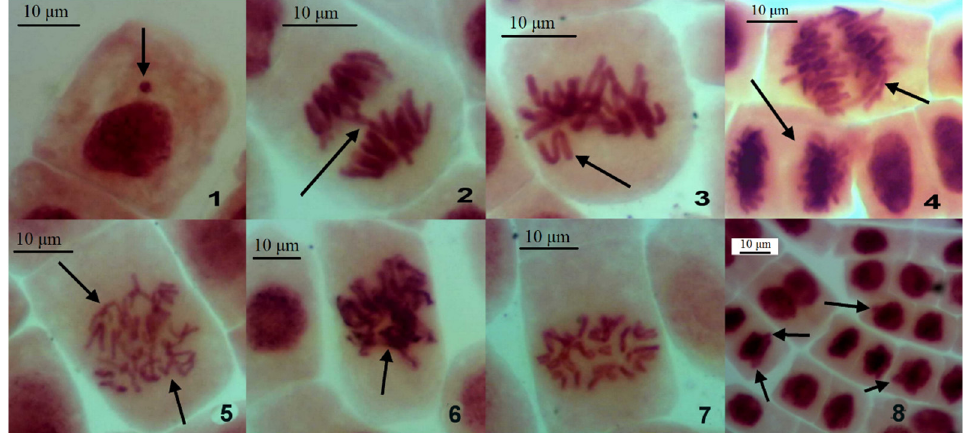
Figure 3. Chromosomal and other aberrations in the dividing cells of A. cepa root meristem after soaking in the water from investigated water bodies. 1—interphase micronucleus; 2—anaphase bridge; 3—chromosome lagging; 4—changed chromosome number in anaphase (top) and telophase (bottom); 5—spindle apparatus abnormality in anaphase; 6—chromosome sticking in metaphase; 7—c-mitosis; 8—nuclear buds. Acetoorcein dying; magnification ×400.